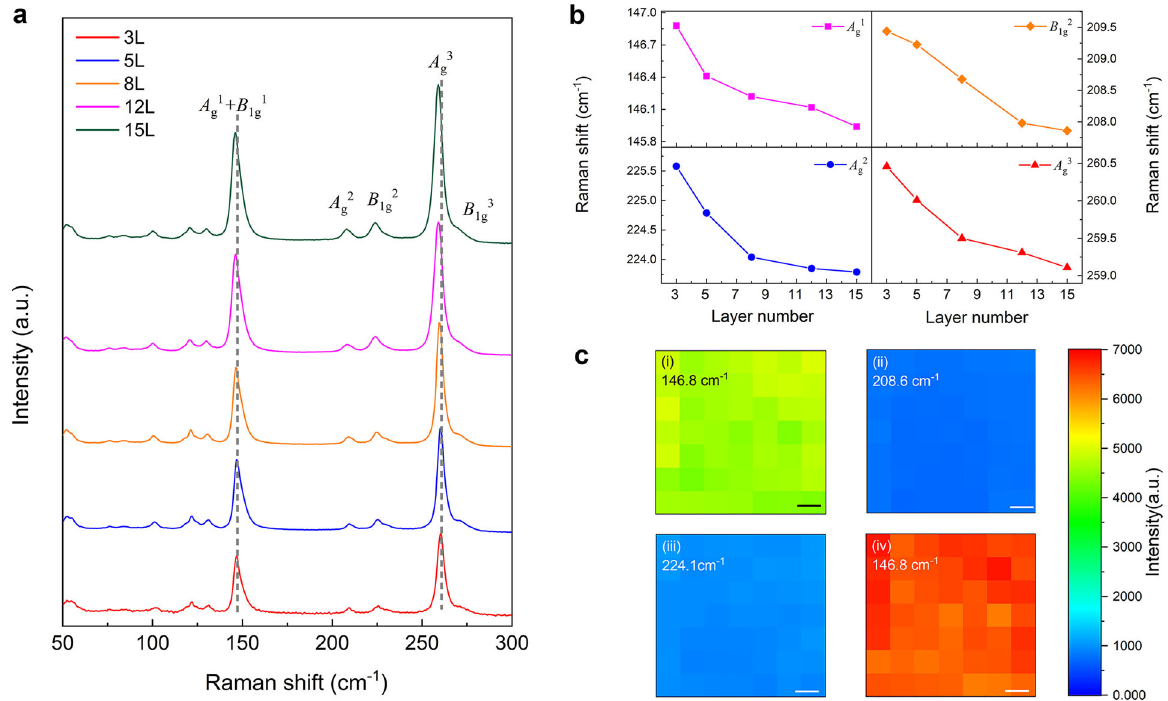
Fig. 2 Raman scattering spectra characterization of centimeter-scale PdSe 2 fi lms. a Raman scattering spectrum of PdSe 2 fi lms with the different number of layers, the dashed line indicates a redshift of the Raman peak position from 3L to 15L. b Raman shifts value of the four main patterns relative to the number of layers from 3L to 15L. c Raman mapping spectrum of 8L PdSe 2 fi lms. The mapping range was 7*7 mm with 1 mm intervals. (i) – (iv) Characterized the Raman intensity at 146.8, 208.6, 224.1, and 146.8 cm − 1 , respectively. The scale bar is 1